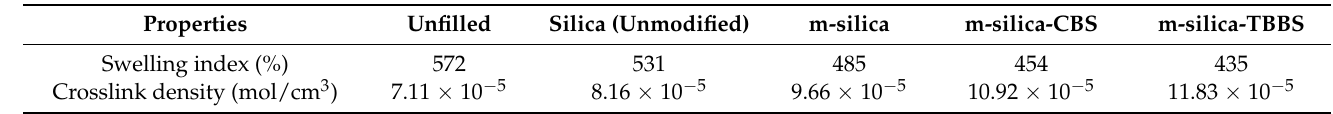
Table 5. The swelling index and the crosslink density of unfilled natural rubber and natural rubber filled with silica (unmodified), m-silica, m-silica-CBS, and